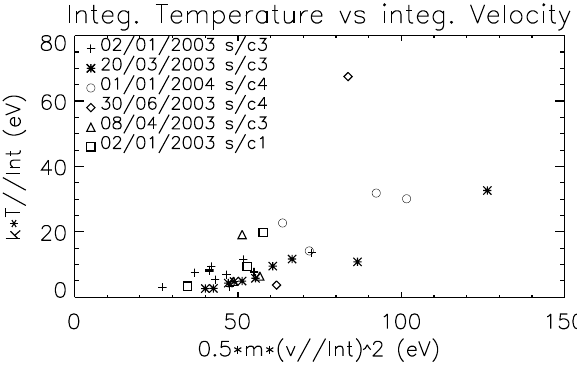
Fig. 6. Beam integrated temperature T // int as a function of the en- ergy corresponding to their average velocities (1/2m.v 2 different symbols correspond to different days.